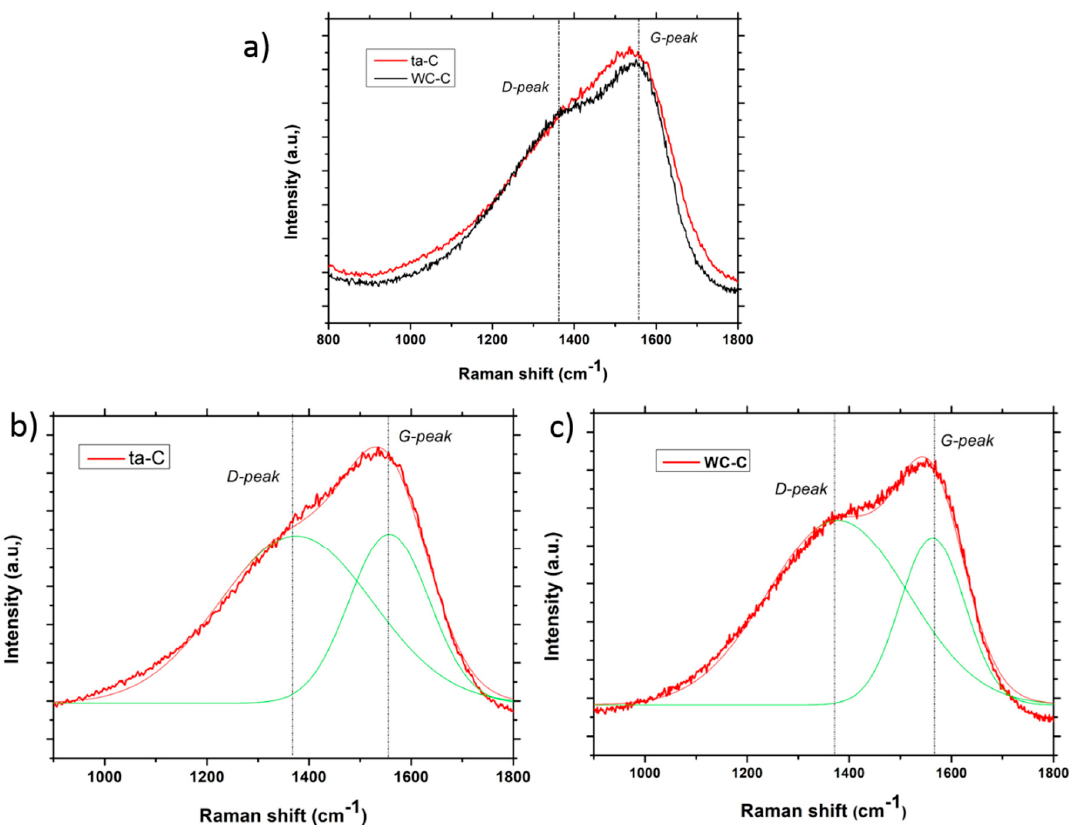
Figure 5. ( a ) Raman spectra of the ta-C and WC:C samples. ( b ) Fitting of ta-C sample. ( c ) Fitting of WC:C sample.